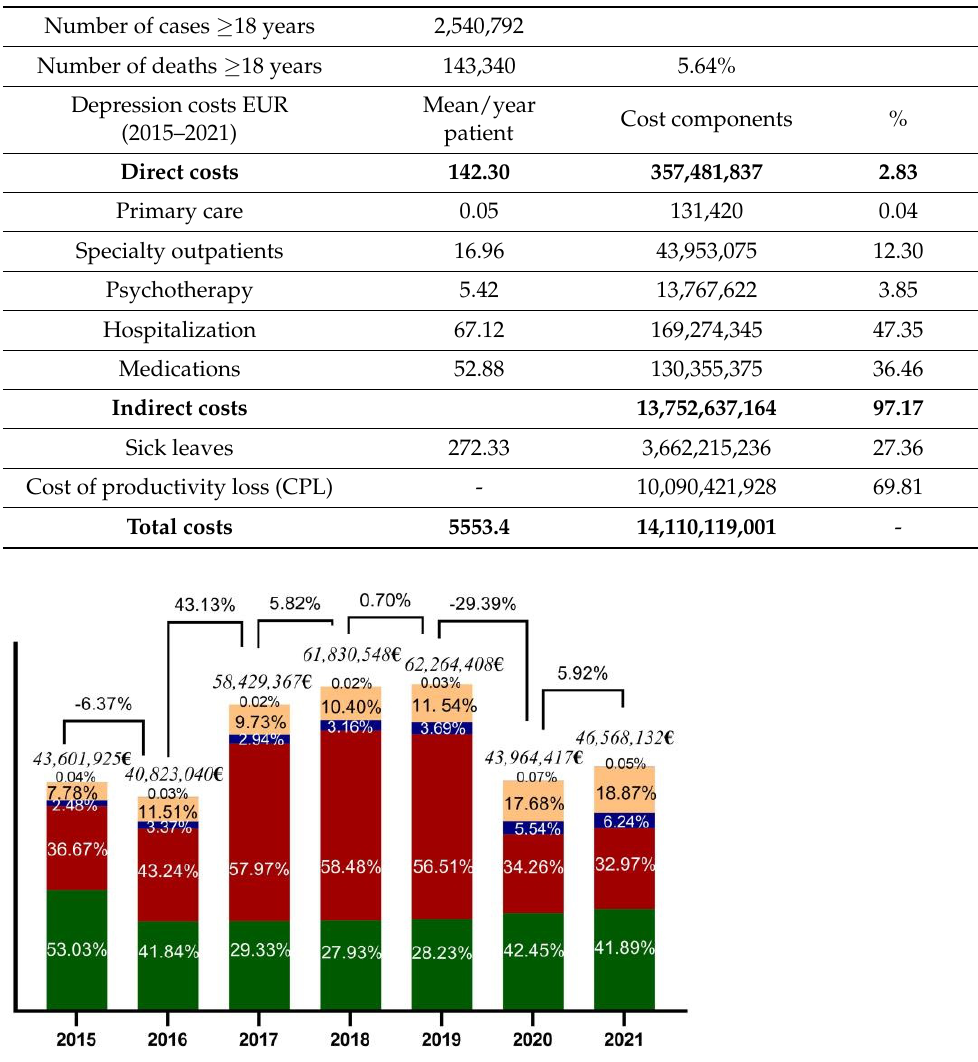
Figure 3. Mean annual patient cost (€) (estimation plot and p -value of t-test). The invalidity cost was 23.59% of the total in 2015, 39.19% in 2016, 20.08% in 2017, 34.22% in 2018, 32.83% in 2019, 32.48% in 2020, and 9.15% in 2021 (Figure 4). The number of deaths recorded in the adult population is increasing along with the prevalence of ill- nesses. The CPL value represented 73.00% in 2015; unfortunately, in 2021, it increased to 89.16% (Figure 4).